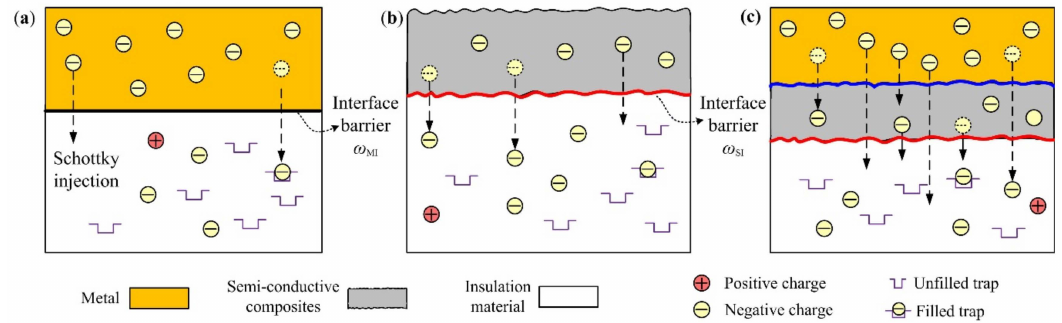
Figure 8. Schematic diagram of charge injection from di ff erent high voltage terminals. ( a ) M-I; ( b ) S-I; ( c )